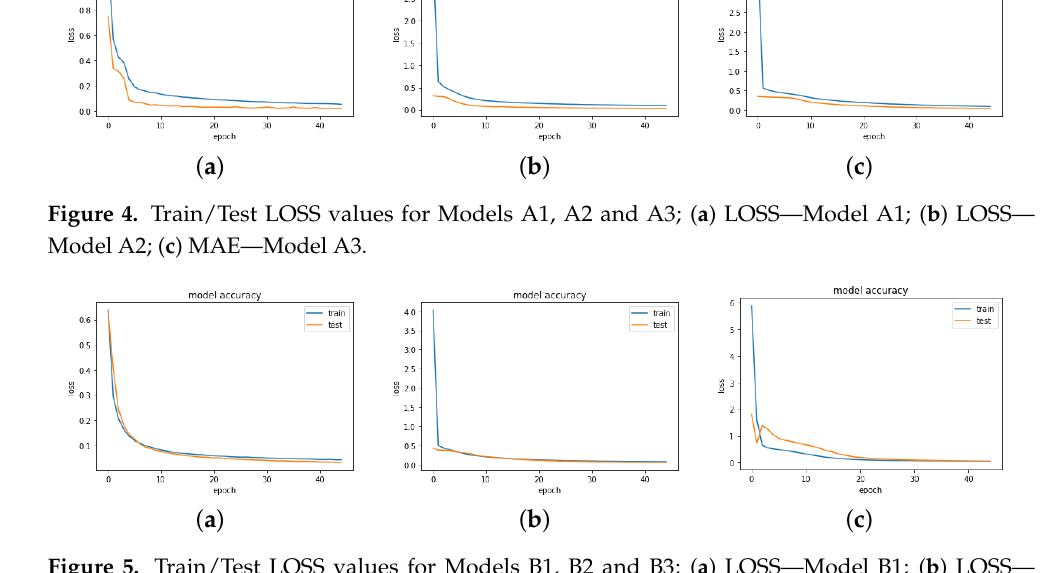
Figure 5. Train/Test LOSS values for Models B1, B2 and B3; ( a ) LOSS—Model B1; ( b ) LOSS— Model B2; ( c ) LOSS—Model